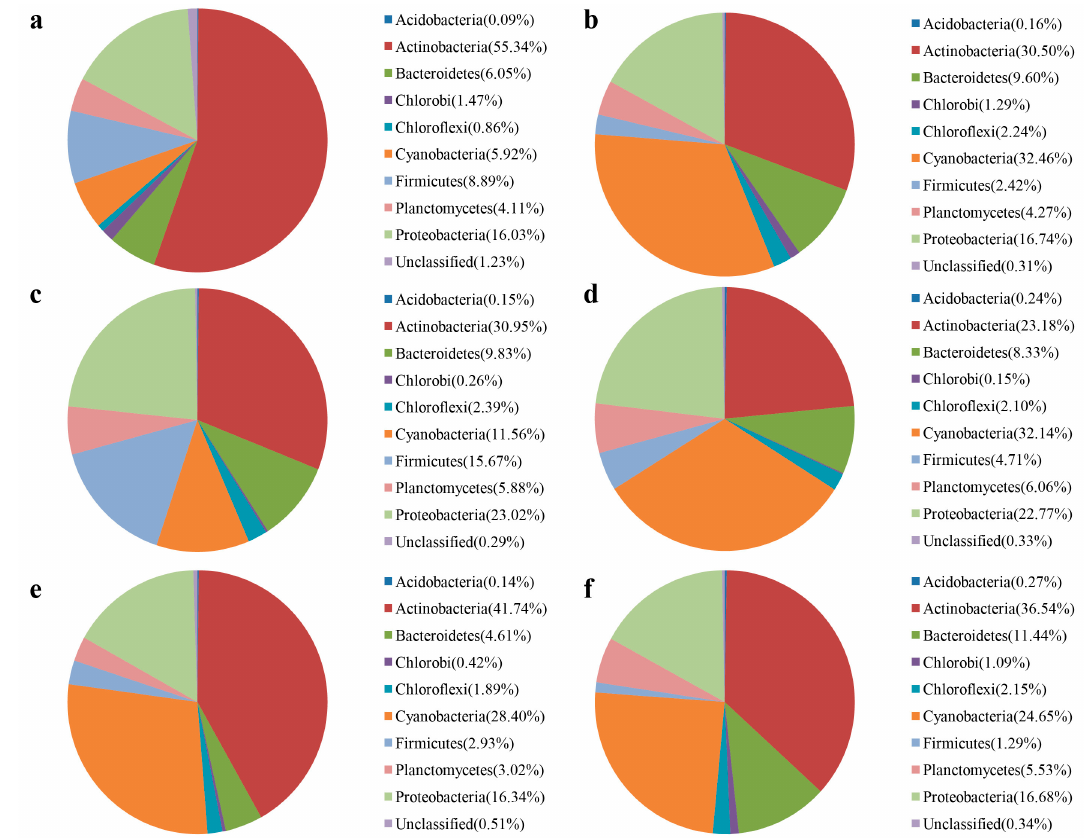
Figure 4. Taxonomic classification of water bacterial community in Zhoucun drinking water reservoir during algal bloom outbreak and decline from July to September, 2012. Phylum levels using the Ribosomal Database Project classifier. a, b, c, d, e, f represent Jul. 13, Jul. 31, Aug. 16, Sep. 1, Sep. 15, Sep. 30 sampling date, respectively.